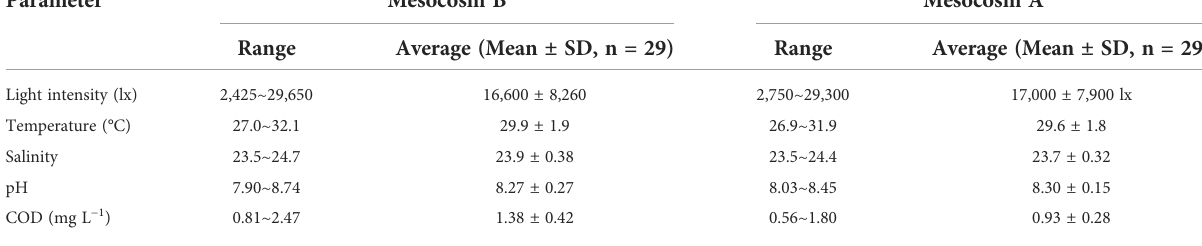
TABLE 2 Comparisons of the main environmental parameters during the